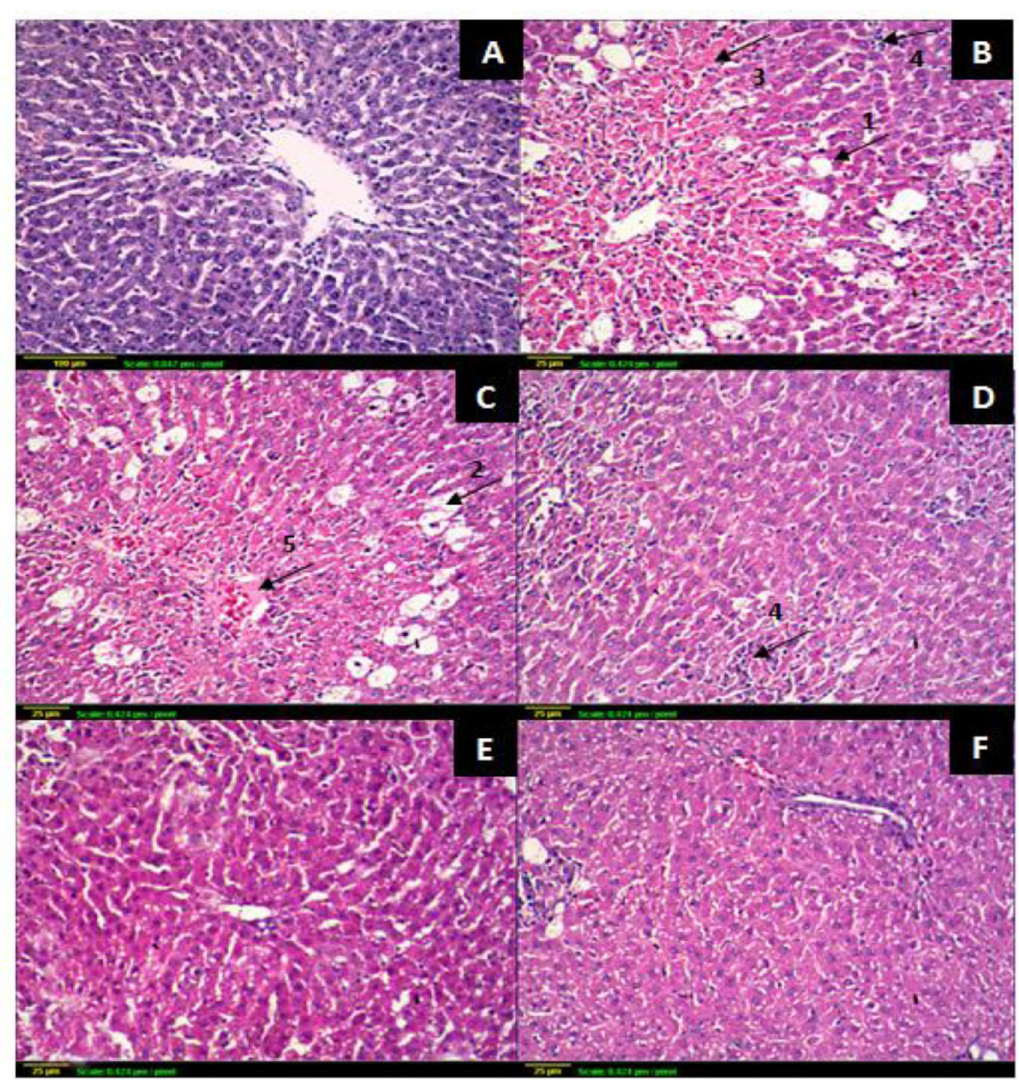
Fig 2. Effect of P . niruri AE on rats liver histopathology after acute CCl 4 intoxication. (A) control portal area and surrounding hepatocytes; (B) CCl